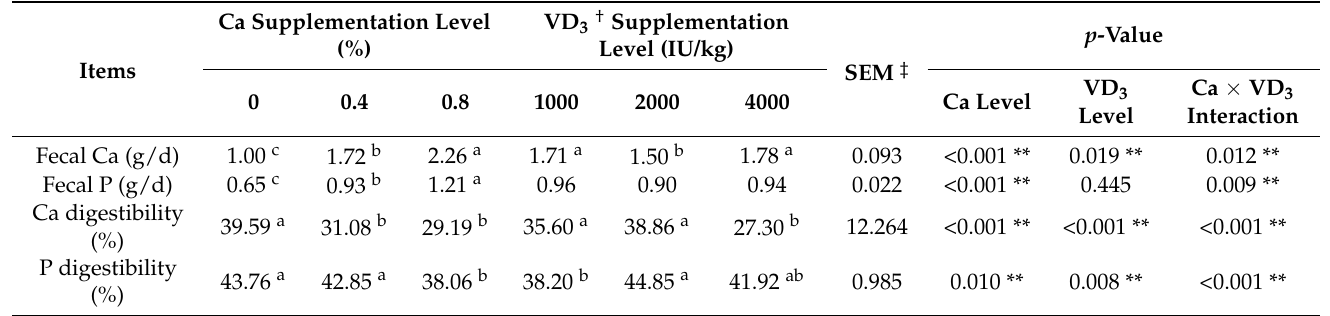
Table 5. Effects of dietary Ca and VD 3 supplemental levels on Ca and P digestibility in growing blue foxes (LS means ±